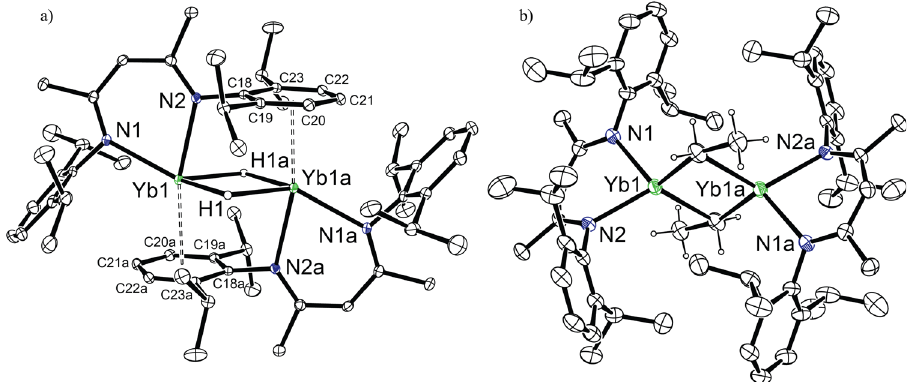
Fig. 3 Crystal structures of compounds 2 and 3. ORTEP representations (30% probability ellipsoids) of ( a ) compound 2 , ( a = 1 – x , – y , – z ); and ( b ) compound 3 ( a = 1 – x , – y , – z ). Hydrogen atoms, except the bridging H atoms in 2 and those attached to the α -and β - carbons of 3 have been removed for clarity. Selected bond lengths [Å] and angles [°]: 2 ,: Yb1-N1 2.4373(15), Yb1-N1 2.4950(16), Yb1-Cent1 2.7099(9), Yb1-C18 a 3.086, Yb1-C19 a 3.090, Yb1- C20 a 3.018, Yb1-C21 a 3.004, Yb1-C22 a 3.036, Yb1-C23 a 3.081. N1-Yb1-N2 74.05(5), N1-Yb1-Cent1 a 119.44(4), N2-Yb1-Cent1 a 166.38(4). 3 : Yb1-C31